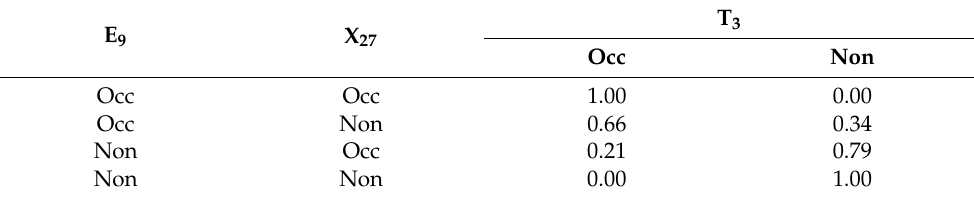
Table A11. The CPT of event T 3 (Human-organization factors; Occ: occurred; Non: non-occurred).